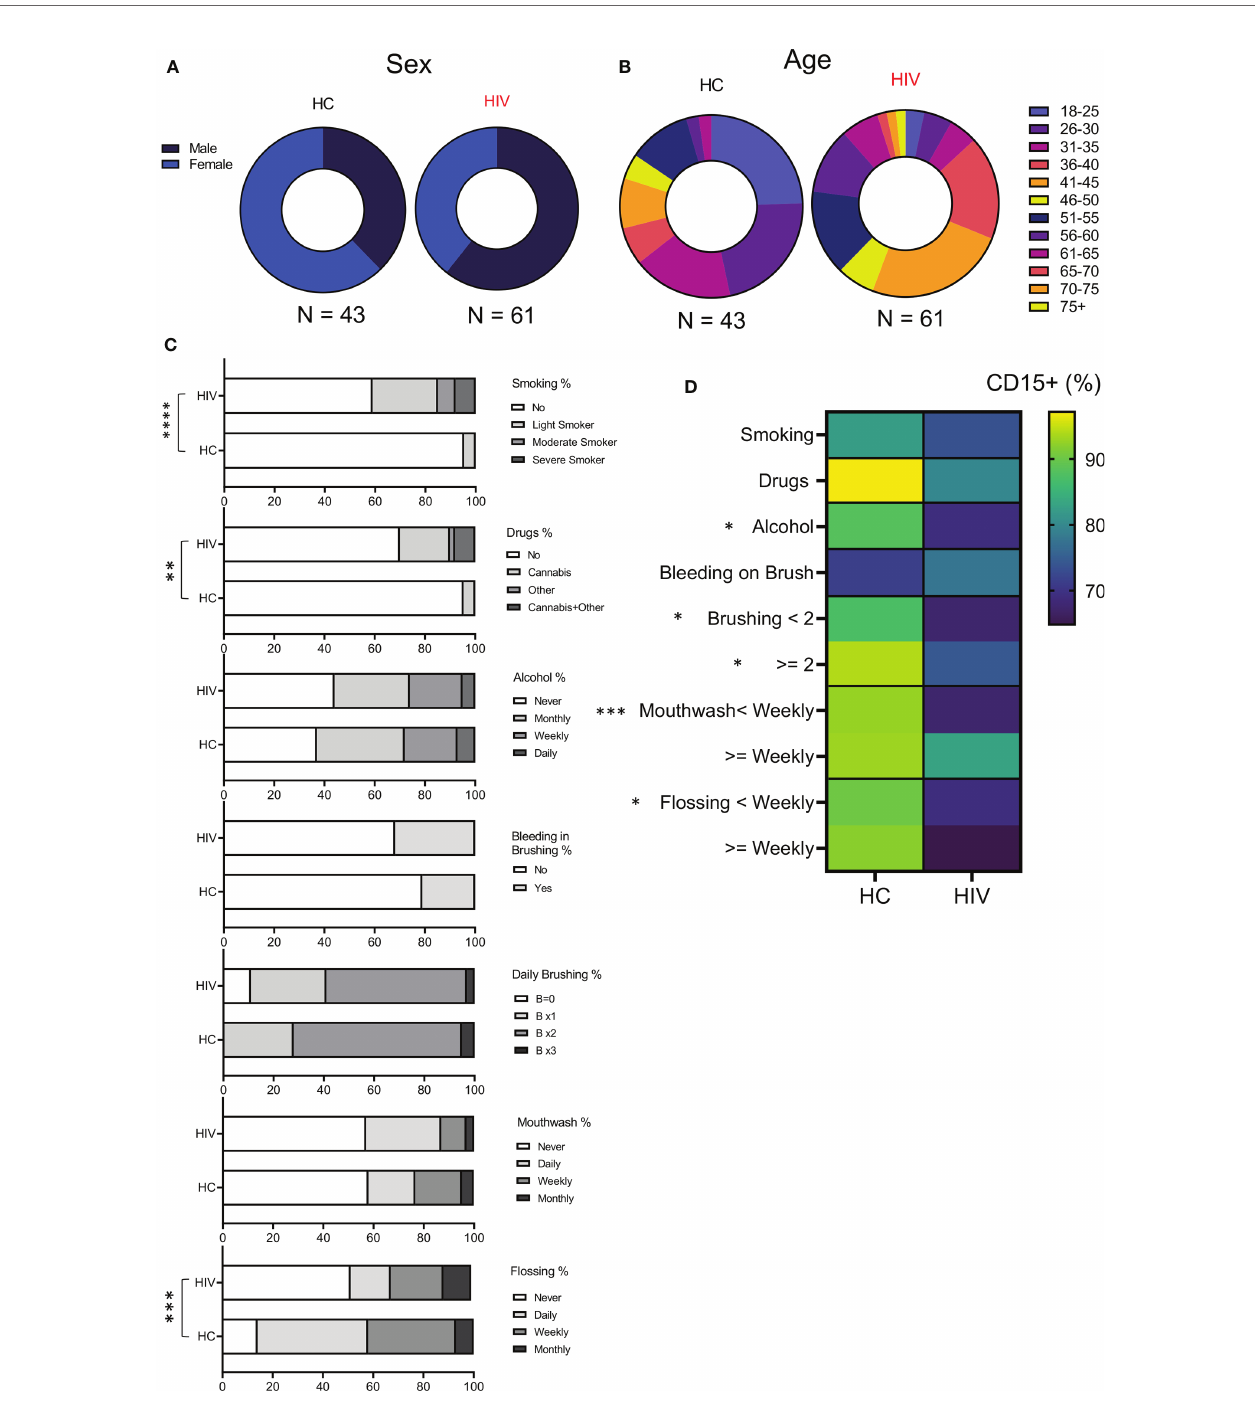
FIGURE 5 | Demographics and habits assessment of participants. (A) Showing the sex distribution with 37% and 63% females and males, respectively in HCs, 61% and 39% for males and females in HIV-infected group. (B) Showing the age distribution among participants. HC group was enriched with younger population according to Fischer ’ s exact test analysis (P = 0.02). (C) Cumulative data illustrating participant ’ s habits such as smoking, drug use, alcohol consumption, daily oral health. (D) Cumulative data showing the correlation of neutrophils ’ percentages with study participants ’ habits. (****P < 0.0001, ***P = 0.0001, **P < 0.001, *P <